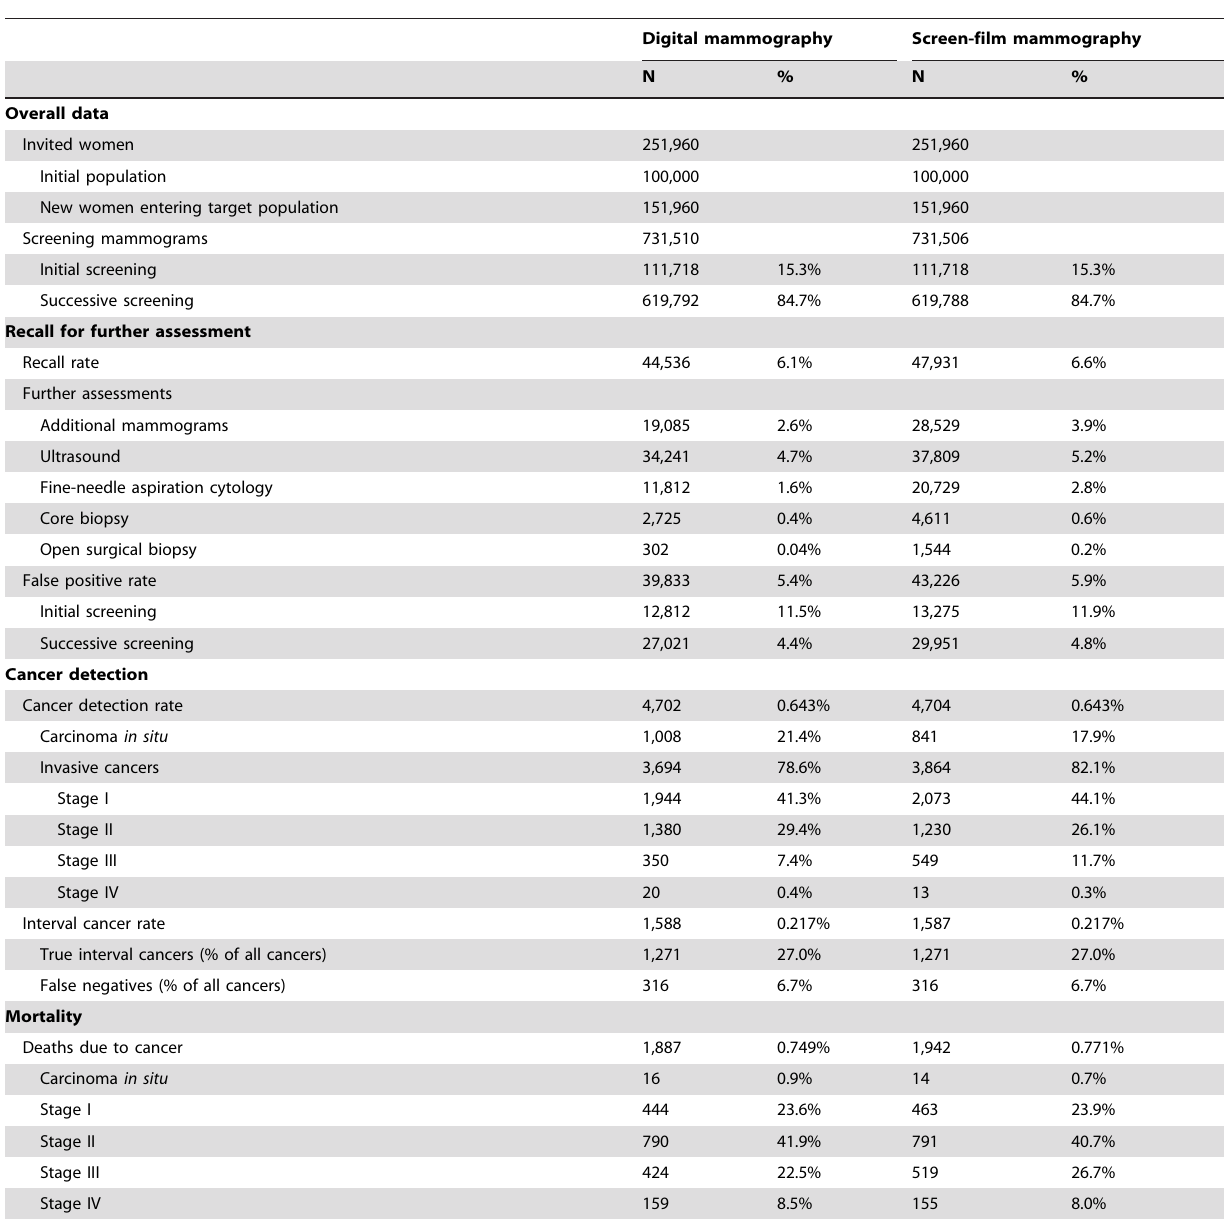
Table 2. Twenty-year cumulative results on health and validation outcomes, according to type of